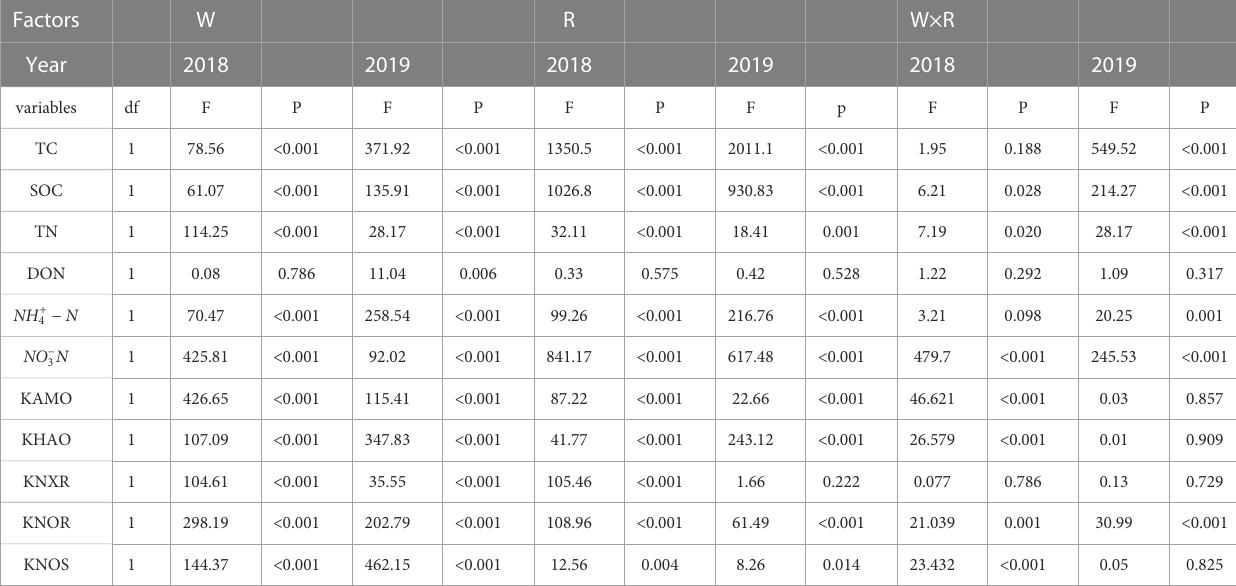
TABLE 3 Results ( df , F and P ) of two-way analysis of variances (ANOVA) for the separate and interactive effects of warming (W) and reclamation effects on soil total carbon (TC), soil dissolved carbon concentration (SOC), soil total nitrogen (TN), soil dissolved organic nitrogen (DON), soil ammonium concentration ( NH + 4 N ), soil nitrate concentration ( NO 3 N ), and the enzymatic activity of AMO, HAO, NXR, NOR and NOS (KAMO, KHAO, KNXR, KNOR,